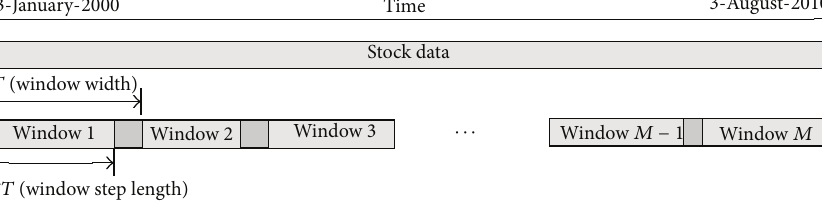
Figure 1: The data windowing method and